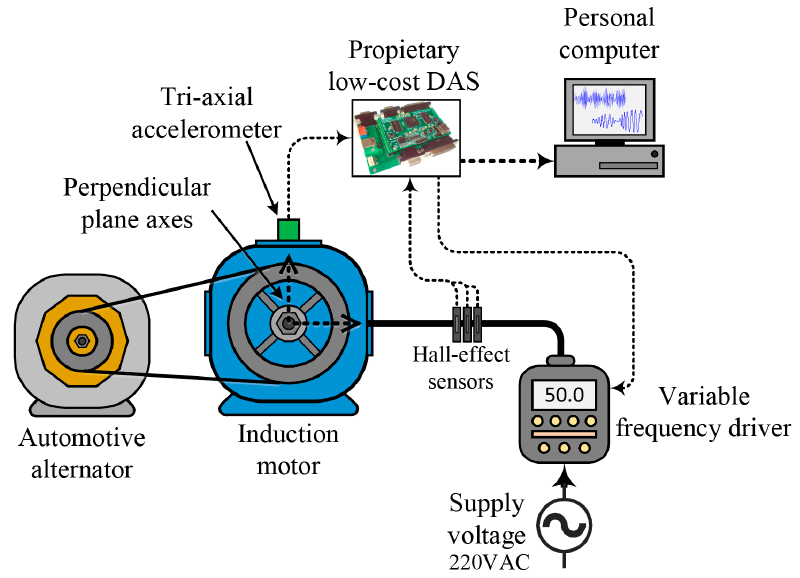
Figure 4. A flow chart of the electromechanical system based on a pulley-belt system and its wiring to perform the acquisition of vibrations signals and the stator current signature.